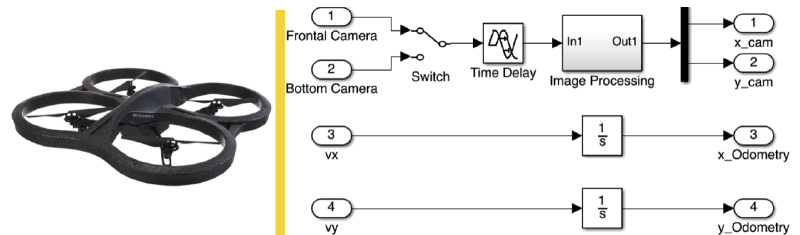
Figure 5. Sensors used for position estimation of the AR.Drone in the x, y plane.